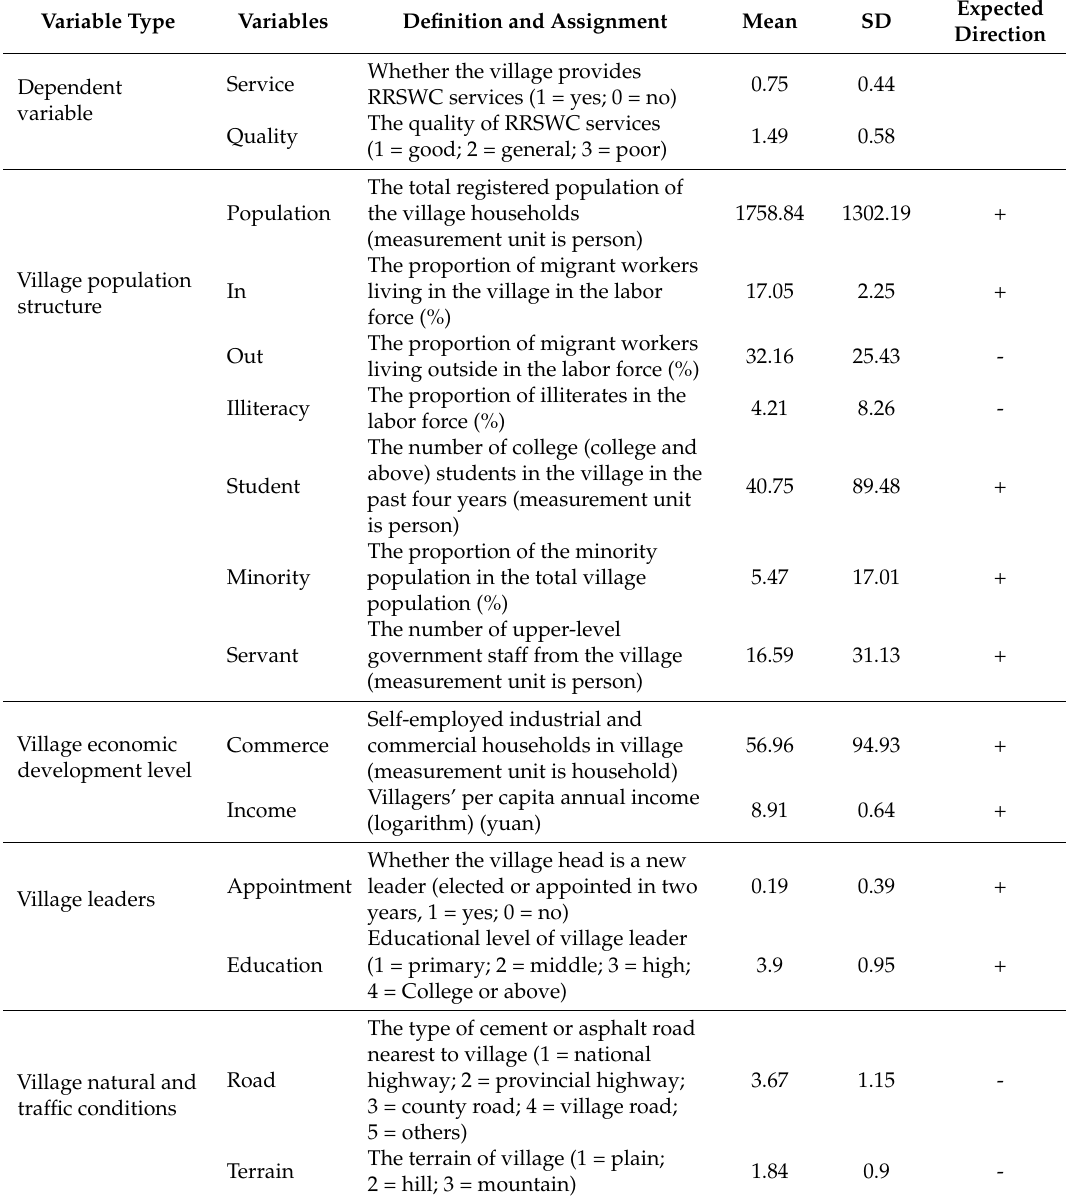
Table 1. The definition and data description of the variables involving in the model 1